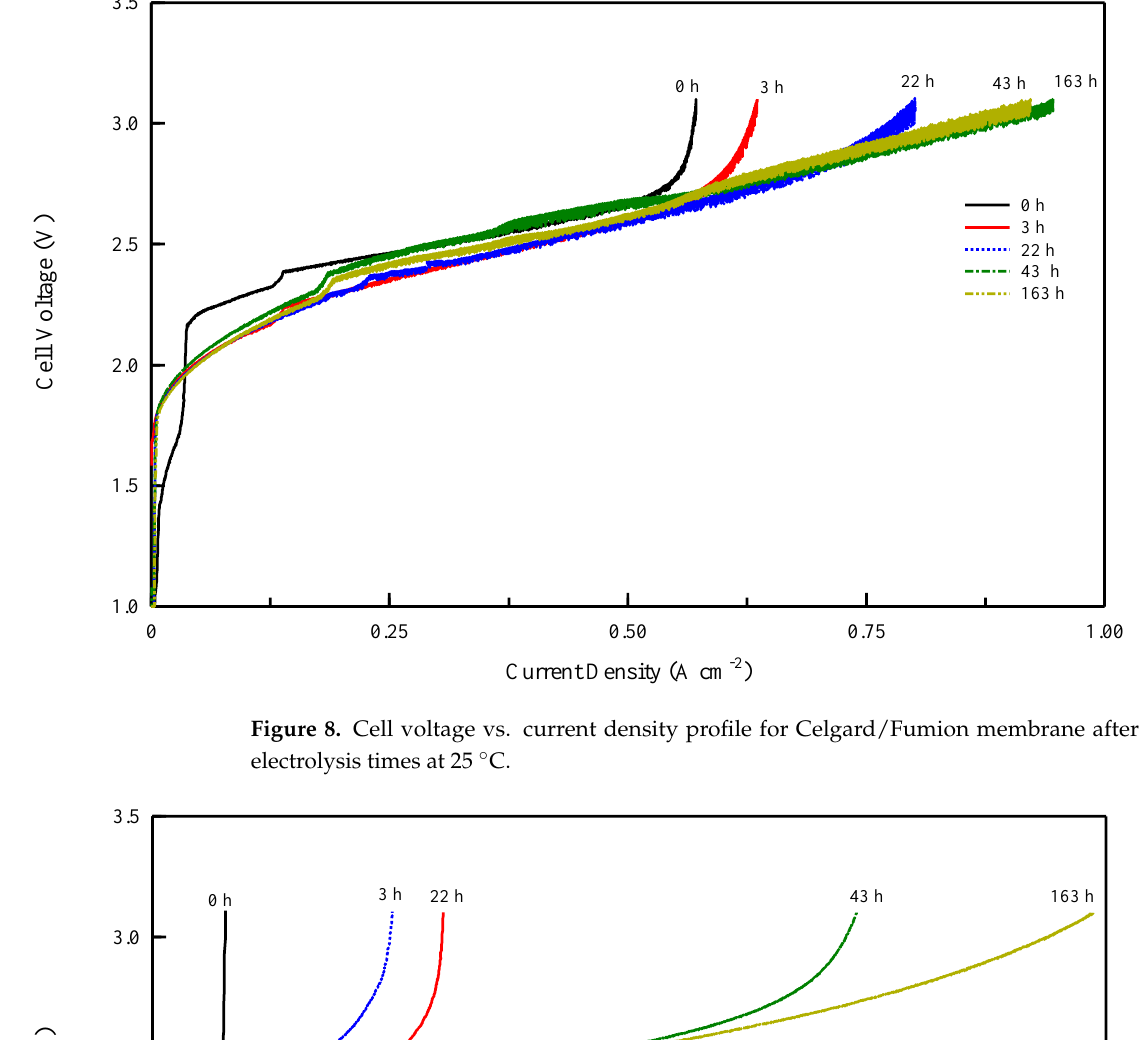
Figure 8. Cell voltage vs. current density profile for Celgard/Fumion membrane after different electrolysis times at 25 °C.